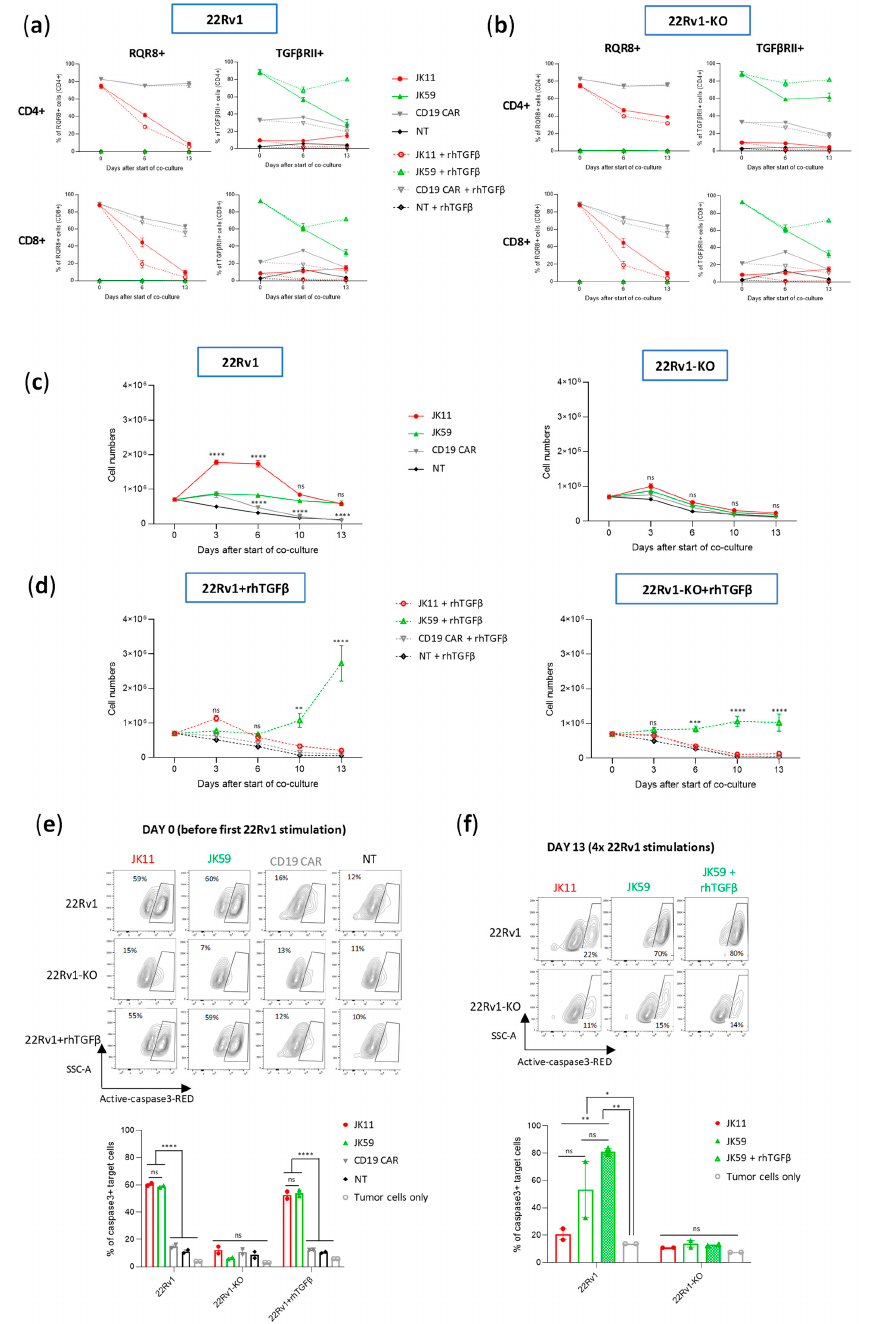
Figure 5. TGF β enhances the proliferation and functionality of SwR-STEAP1 CAR T cells after repeated in vitro stimulation with tumor cells. Freeze-thawed and activated JK11, JK59, and CD19 CAR T cells, and non-transduced (NT) control T cells, were co-cultured with irradiated (20 Gy) 22Rv1 and 22Rv1-KO target cells in the absence or presence of 10 ng/mL rhTGF β at an E:T ratio of 1:1 for 3 to 4 days. Every 3 to 4 days, the T cell number was measured, and the same T cells were co-cultured again on freshly irradiated target cells for 3 to 4 more days until day 13. ( a ) Graphs representing the CAR expression of JK11, JK59, and CD19 CAR T cells and non-transduced (NT) T cells following co-culture with 22Rv1 target cells at days 0, 6, and 13. ( b ) Graphs representing the CAR expression of JK11, JK59, and CD19 CAR T cells and non-transduced (NT) T cells following co-culture with 22Rv1-KO target cells at days 0, 6, and 13. In ( a , b ), the CAR expression of JK11 and CD19 CAR T cells was detected with the antibody recognizing the RQR8 sequence (left panels), and the CAR